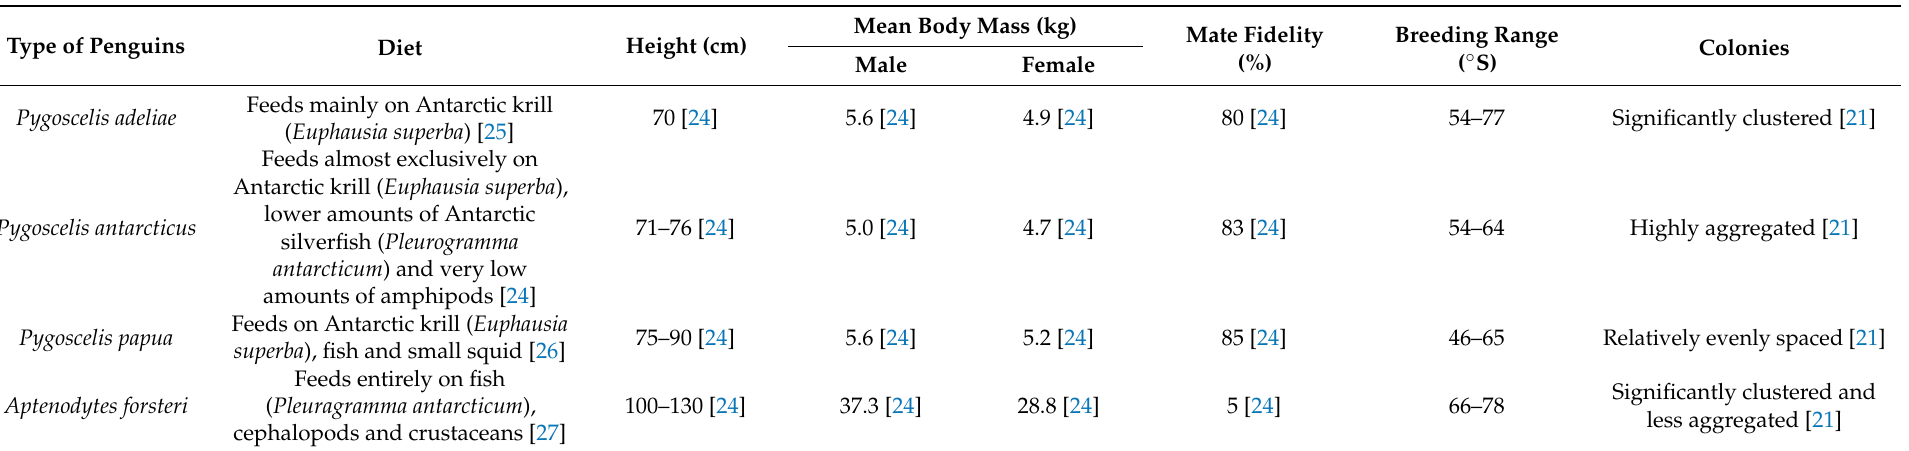
Table 1. Some biological characteristics of Antarctic